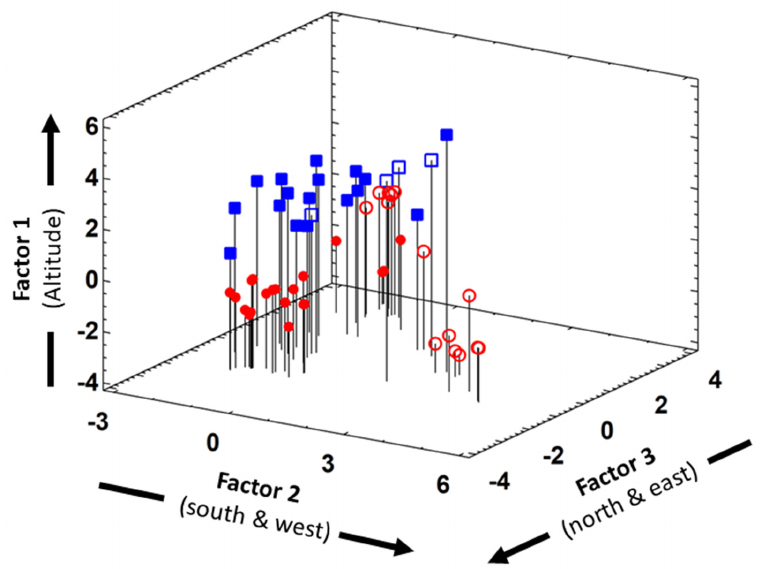
Figure 19. 3D-plot of species association with geographical clines based on factorial analysis. Blue symbols: core altitudinal range of species >2000 m; red symbols: core altitudinal range of species <2000 m. Filled symbols: species associated to communities described in Table 2; open symbols: species detected not affiliated to a community in Table